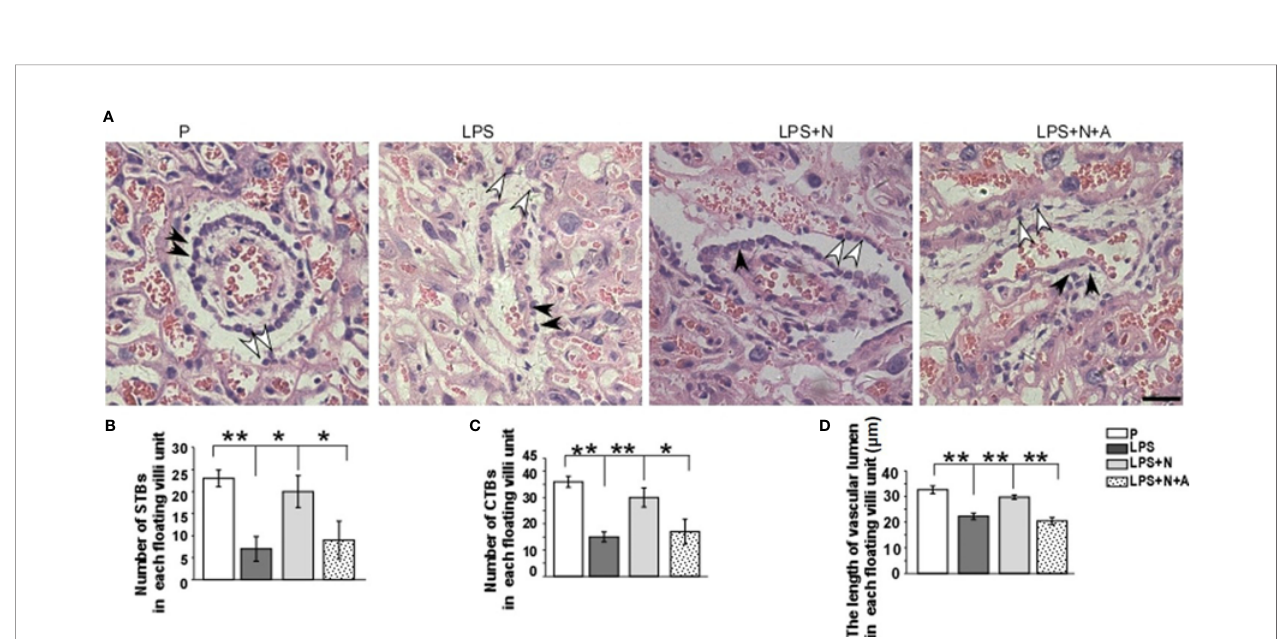
FIGURE 2 | PE is associated with a striking down-regulation of a7nAChR on decidual macrophages (dMj). (A) Representative immuno fl uorescence images of a7nAChR on dMj in PE patients and normal controls. White arrows indicated positive stained signals. (B) The relative a7nAChR positive dMj immunoreactivity was quanti fi ed as shown in the graph. Scale bar=30 mm. *P <